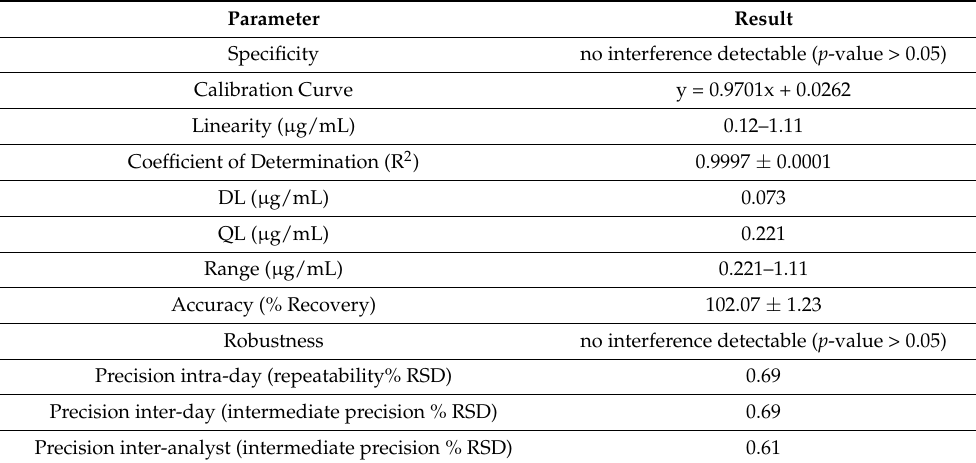
Table 2. Validation parameters.